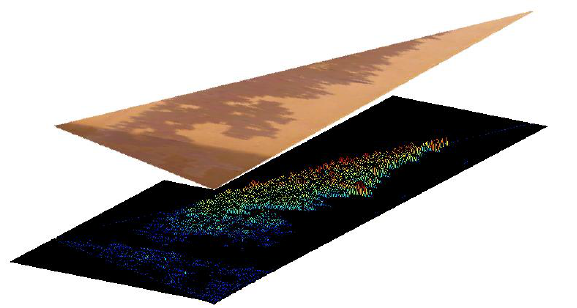
Figure 14. 3D view of image difference of test 3 after radiometric shift and non maxima suppression